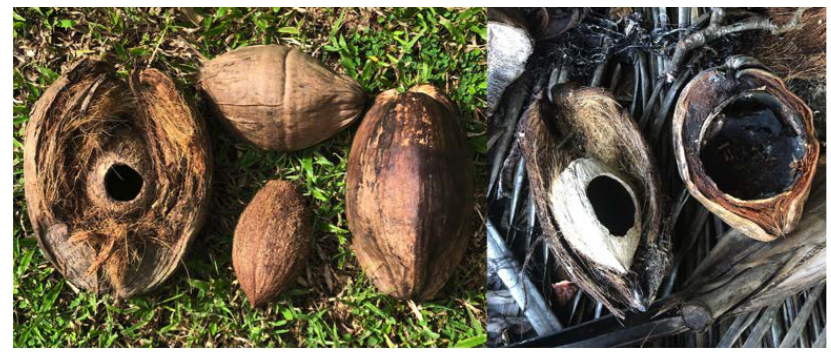
Figure 3. Left: The thick husk and small round kernel of a niu kafa. Middle: a unique small, elongated kernel that comes from the self-sown niu kafa on the right. Top: Small nut that grows on tall trees. Far Right: An elongated niu kafa compared to a small niu vai intermediate type on Four Mile Beach.